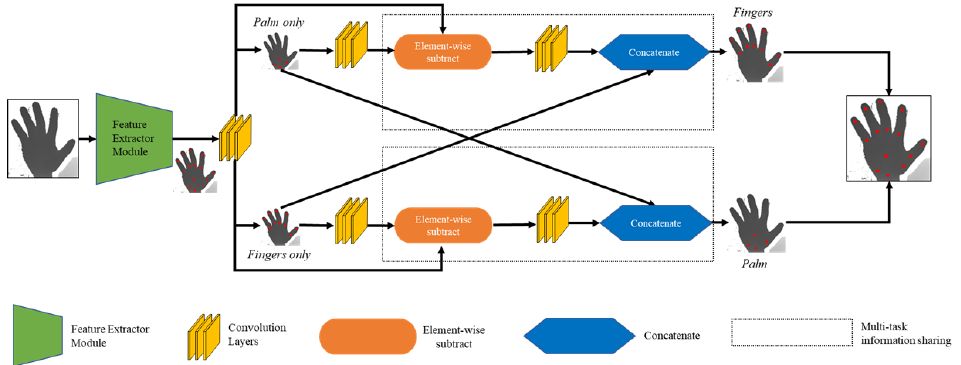
Figure 3. CrossInfoNet structure.